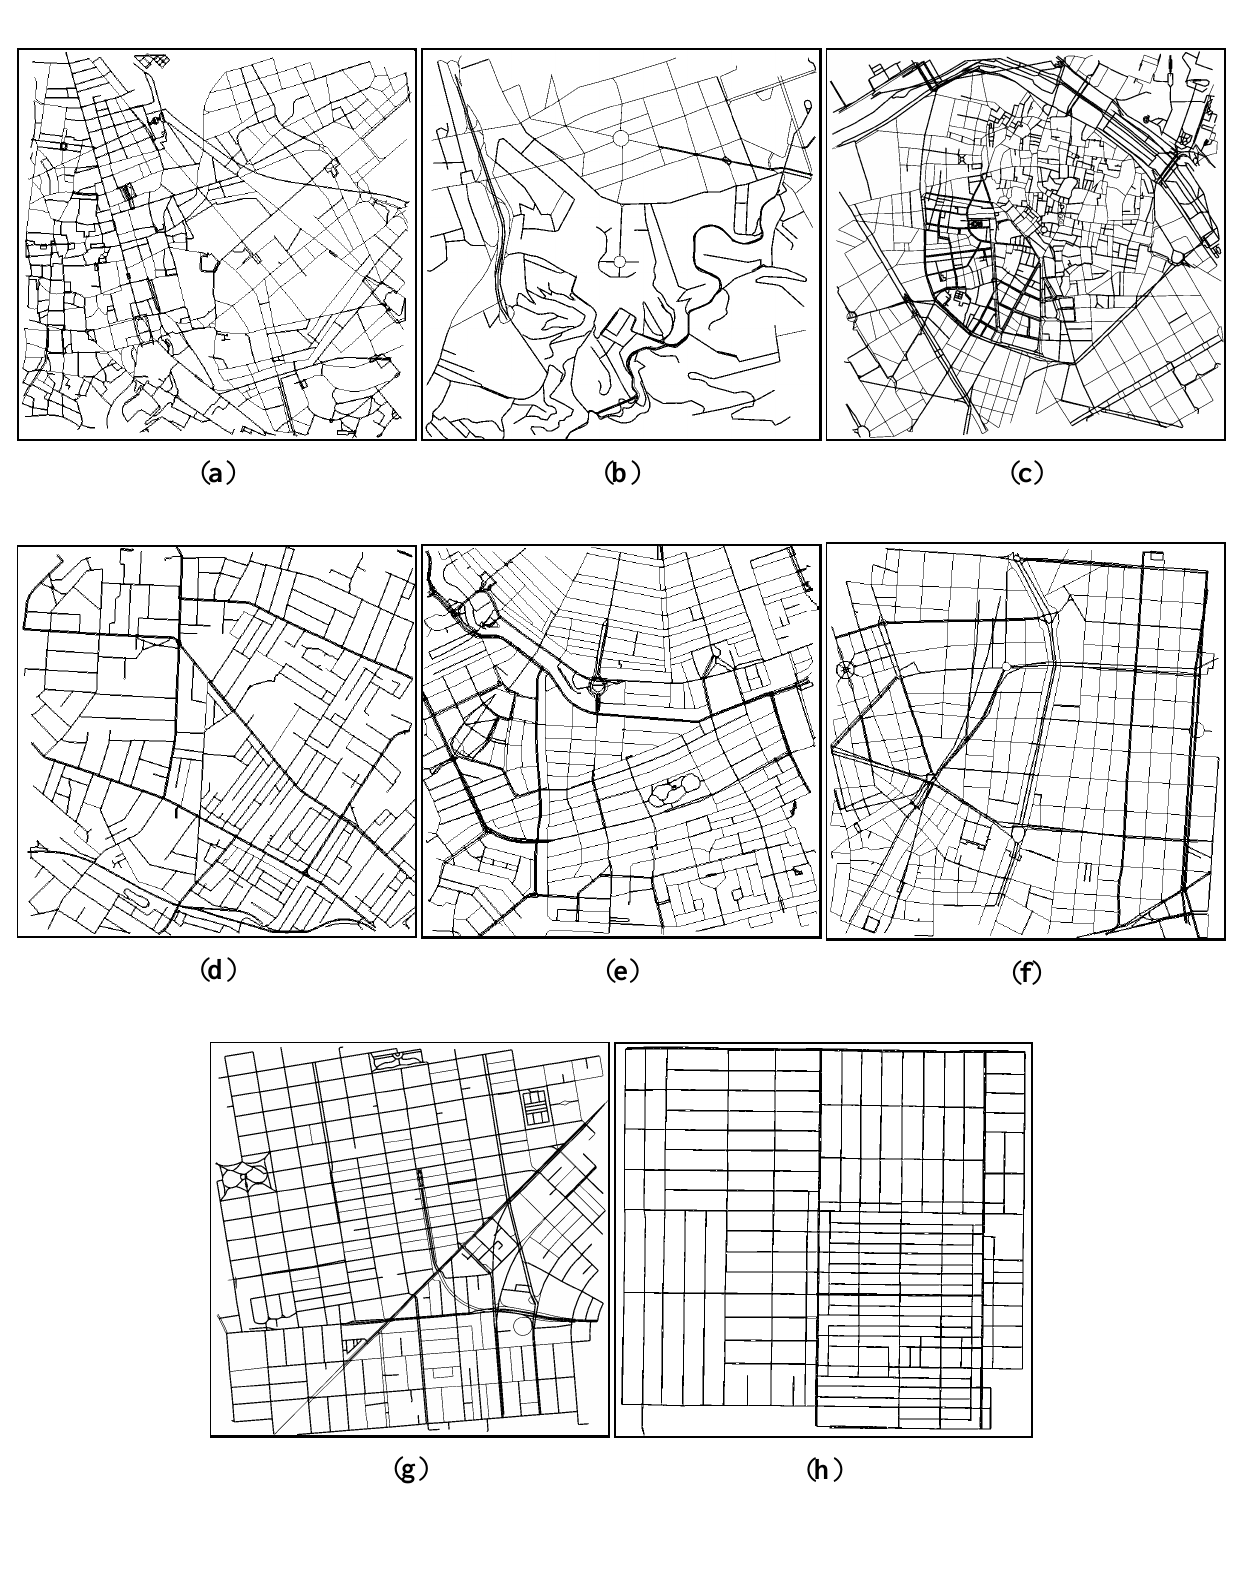
Figure 1. Scenarios used in our simulations. Fragments of the cities of: ( a ) Rome (Italy), ( b ) Rio de Janeiro (Brazil), ( c ) Valencia (Spain), ( d ) Sydney (Australia), ( e )